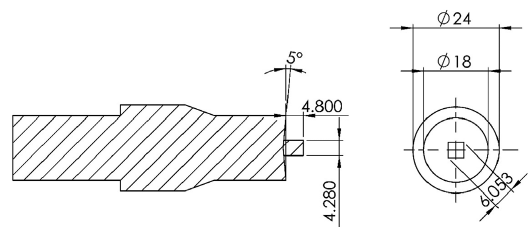
Figure 2. Side and top views of FSW